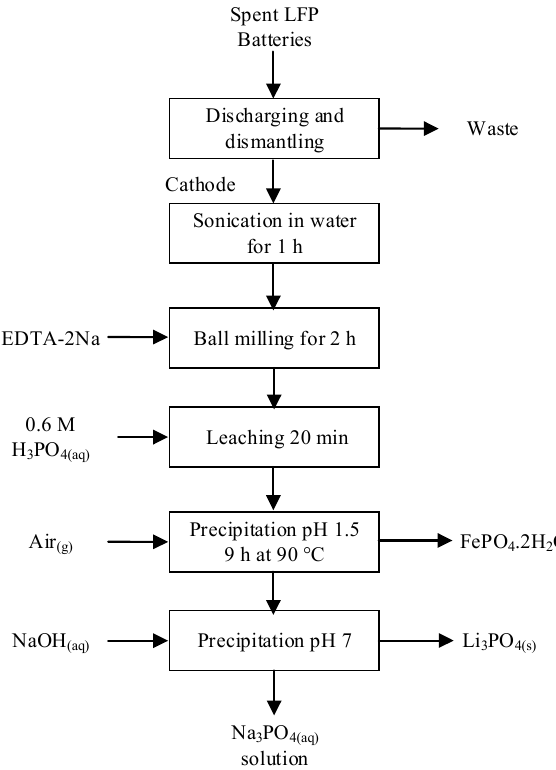
Figure 13. H 3 PO 4 leaching process suggested by Yang et al. (according to [76]); here, LFP and EDTA-2Na are for LiFePO 4 and ethylenediamine tetraacetic acid disodium salt, respectively.